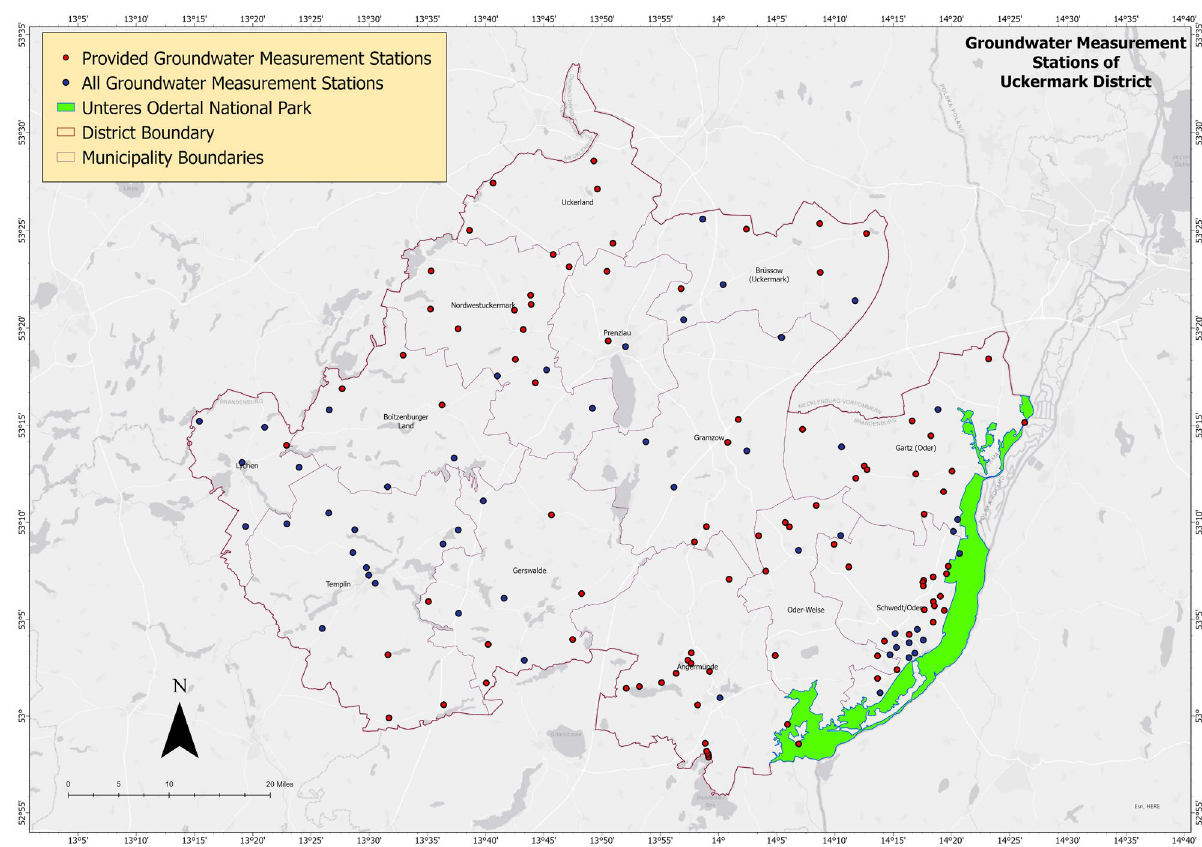
Figure 5. Groundwater measurement stations of Uckermark